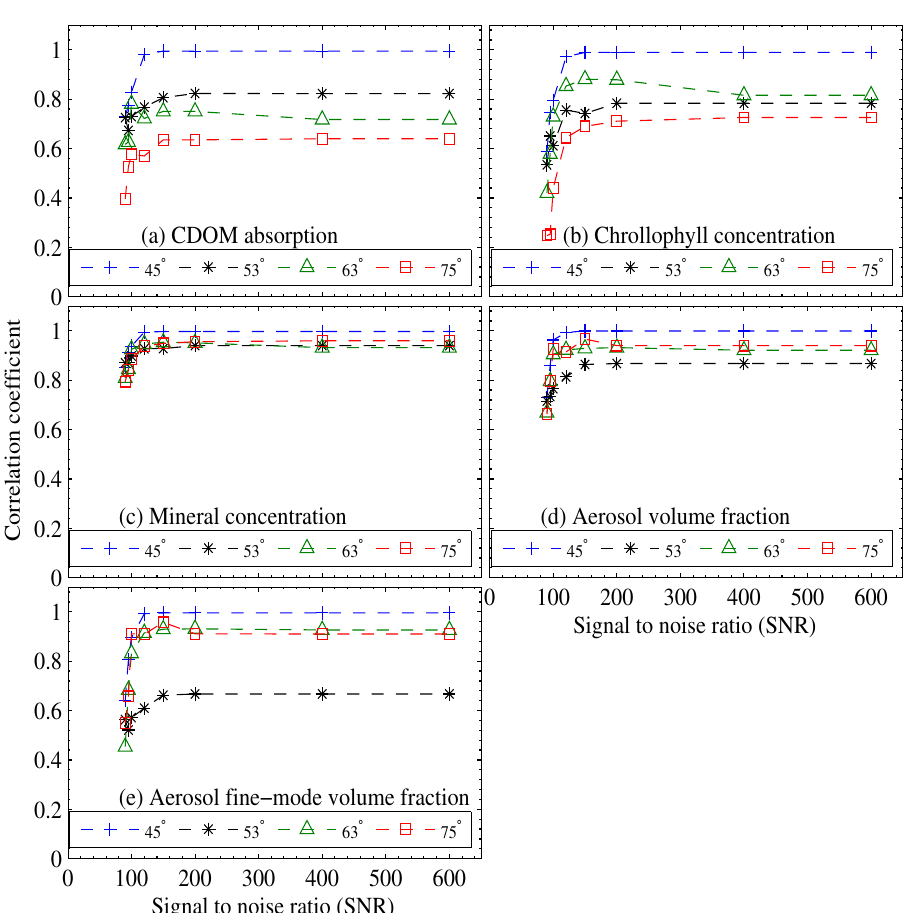
Figure 9. Effects of white Gaussian noise on the retrieved